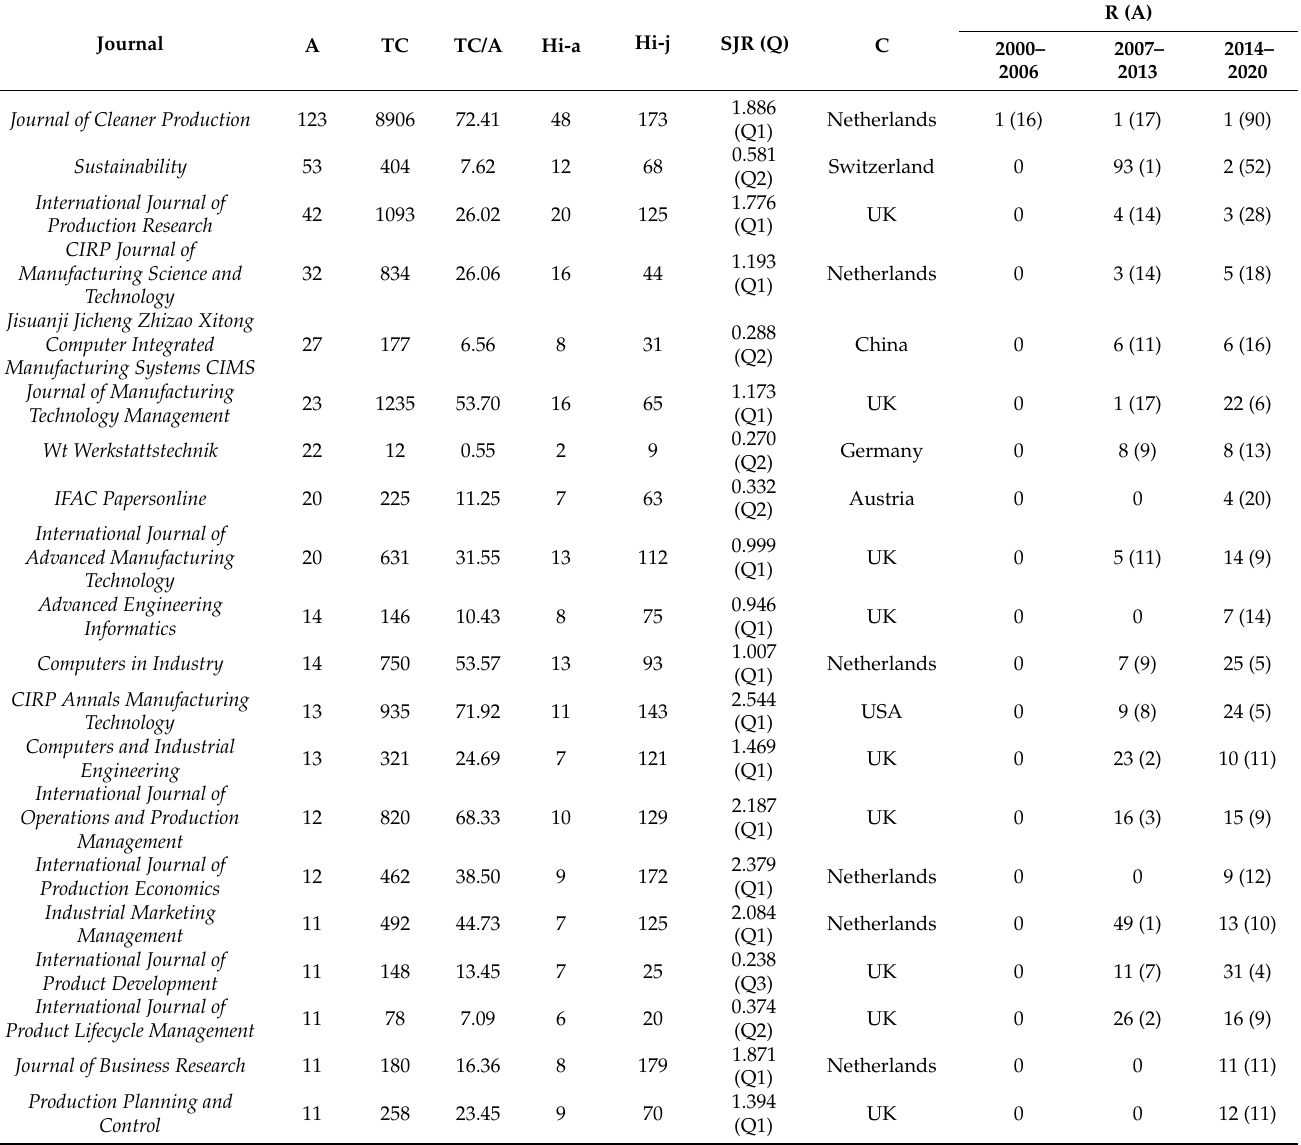
Table 2. The most active journals in PSS from 2000 to